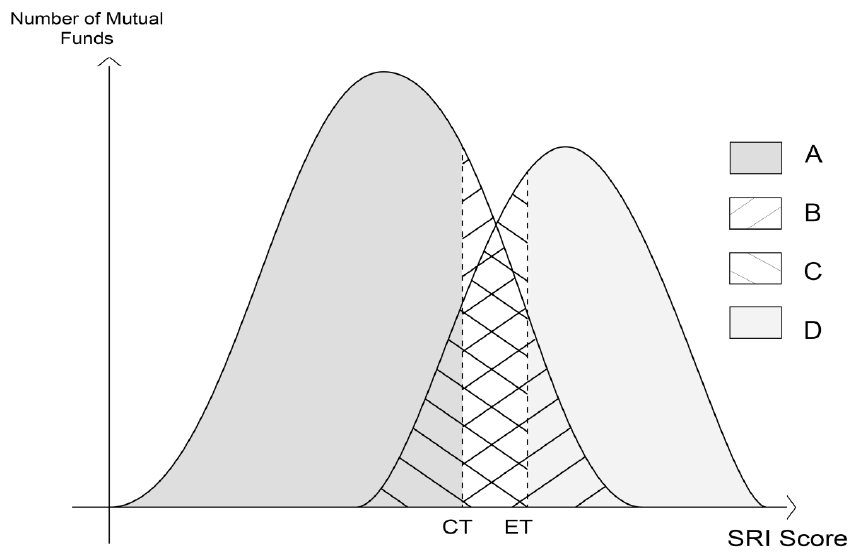
Figure 2. Scheme of the SRI classification from the density function of the SRI score. Notes : This figure is an illustrative scheme of the 2-dimensional measure of SRI. The left-hand distribution corresponds to the conventional mutual funds (category A ∪ B), and the right-hand distribution corresponds to the de jure socially responsible mutual funds (category C ∪ D). Specifically, we define two thresholds ( CT and ET ) to distinguish subcategories (A, B, C and D). Then, mutual funds to the left of the threshold CT (subcategory A) correspond to conventional mutual funds with low scores, whereas mutual funds to the right of the threshold CT (subcategory B) correspond to conventional mutual funds with high scores. Similarly, de jure socially responsible mutual funds to the left of the threshold ET (subcategory C) correspond to de jure socially responsible mutual funds with low scores, whereas mutual funds to the right of the threshold ET (subcategory D) correspond to de jure socially responsible mutual funds with high